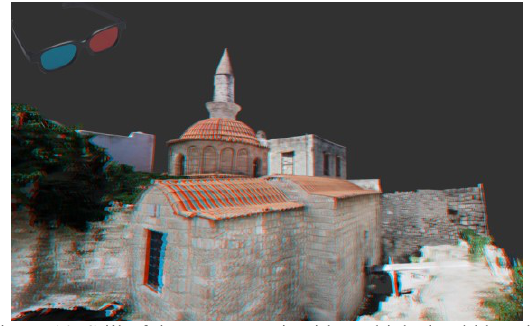
Figure 10. Still of the stereoscopic video which should best be watched with "anaglyph" glasses.